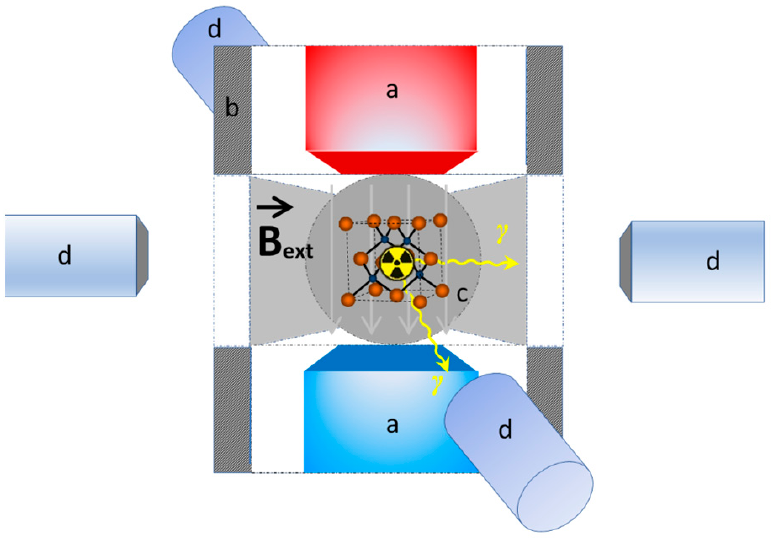
Figure 1. Schematic diagram of the magnetic field setup (0.48 T): Semiconductors doped with a radioactive isotope were placed in a uniform magnetic field, where ( a ) represents the permanent magnets, ( b ) is an iron casing to shield the magnetic field, ( c ) is the position of the sample, and ( d ) are the detectors.